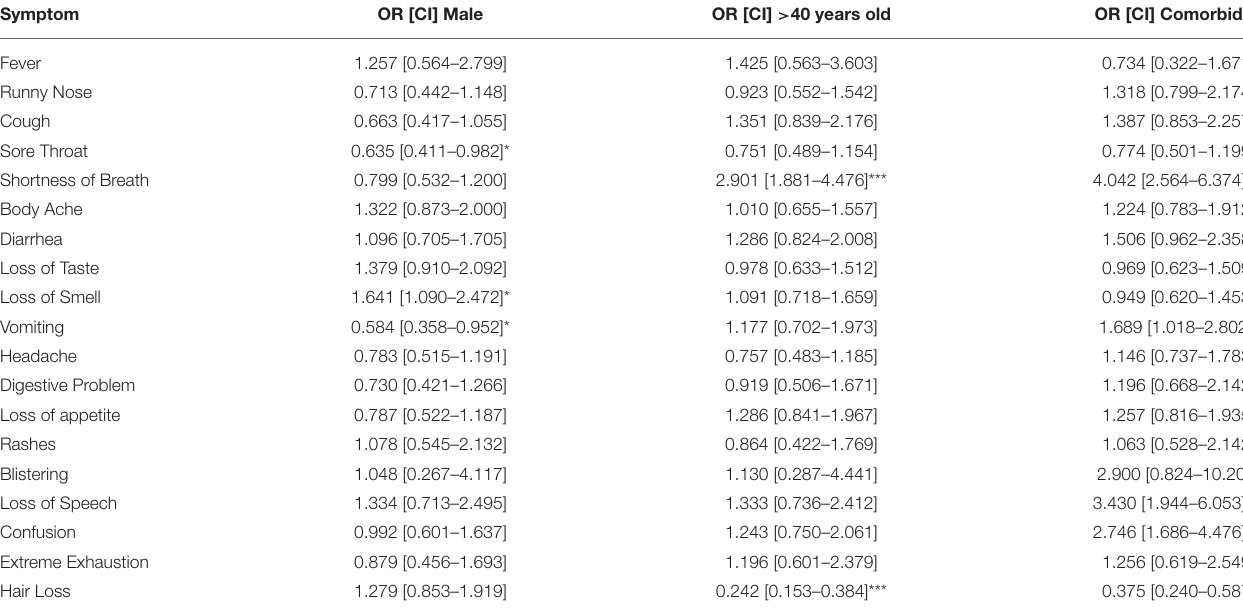
TABLE 4 | Odds Ratios of Covid-19 associated symptoms, Bangladesh, 2020. Symptom OR [CI]